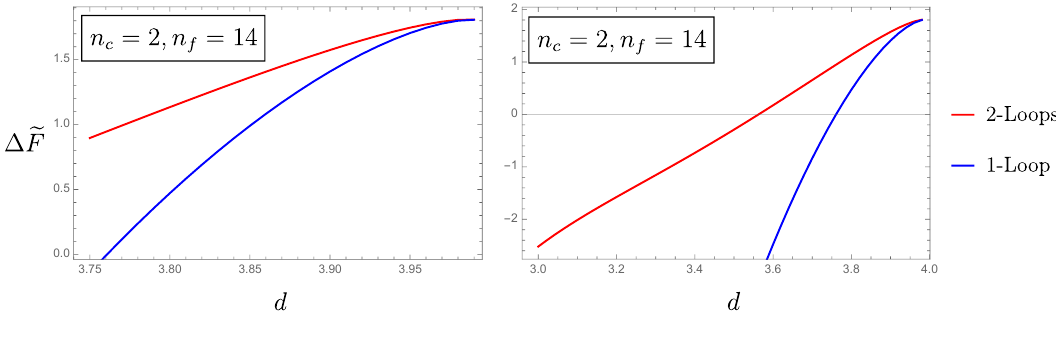
Figure 1 . Left panel: comparison between ∆ e F as a function of the dimension d for small (cid:15) computed by using the result for e F in eq. (4.51) (red) or only its free part given by the first two rows of eq. (4.51) (blue). Right panel: same comparison extended up to d = 3